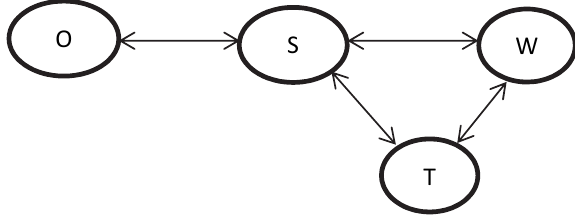
Fig. 3. Interdependencies between SWOT